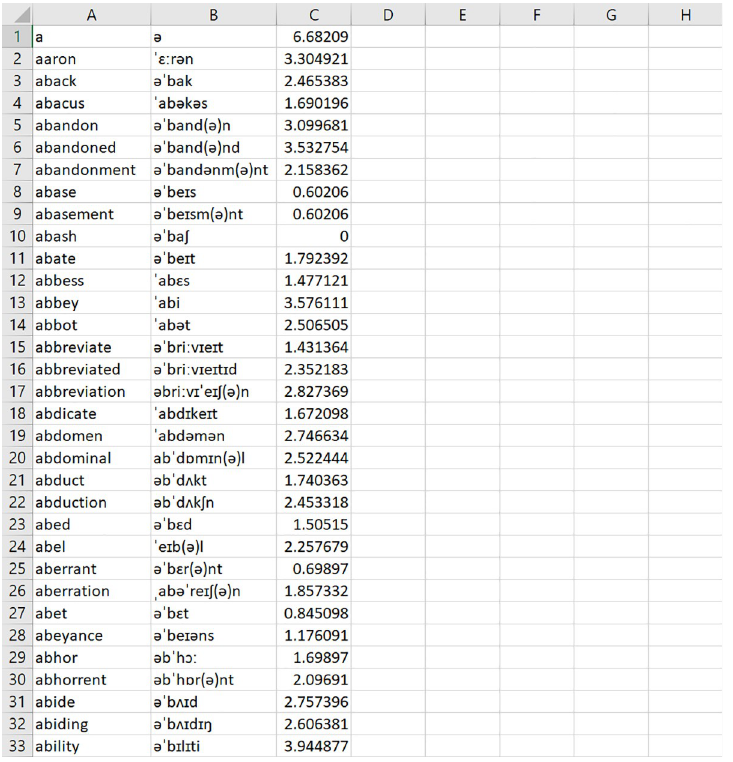
Fig 3. Example of a CSV UTF-8 (comma delimited) corpus file. Orthographic forms are listed in the first column, and corresponding pronunciations (if applicable) are listed in the adjacent column. Word frequencies are listed in the final